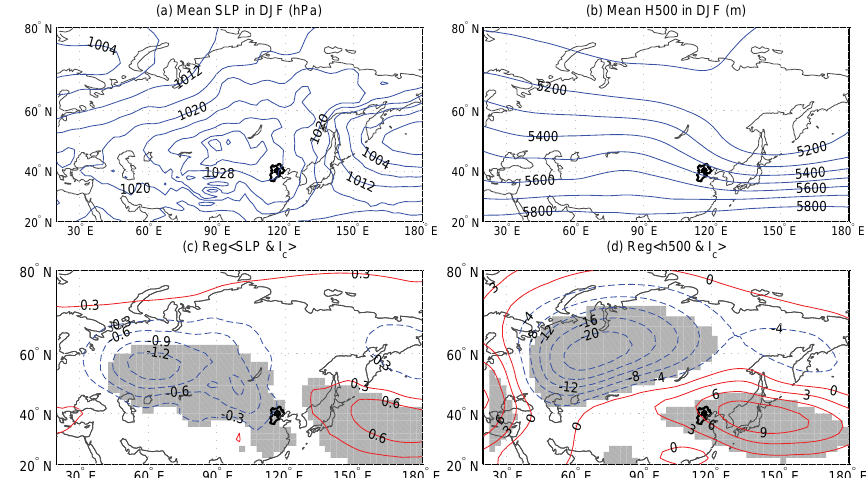
Figure 6. The climatological mean fields of SLP (a) and H500 (b) averaged in winter 1981 to 2010, and the spatial distribution of the regression coefficients of SLP (c) and H500 (d) upon the I c over the period 1981 to 2015 (areas significant at the 0.05 level are shaded).